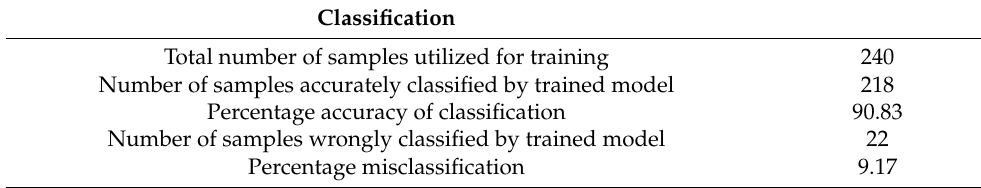
Table 8. Classification results summary considering blind dataset.